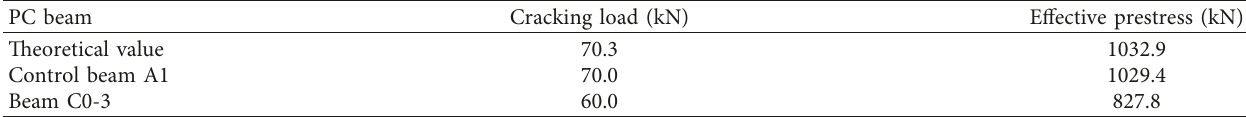
Table 4: The effective prestress.